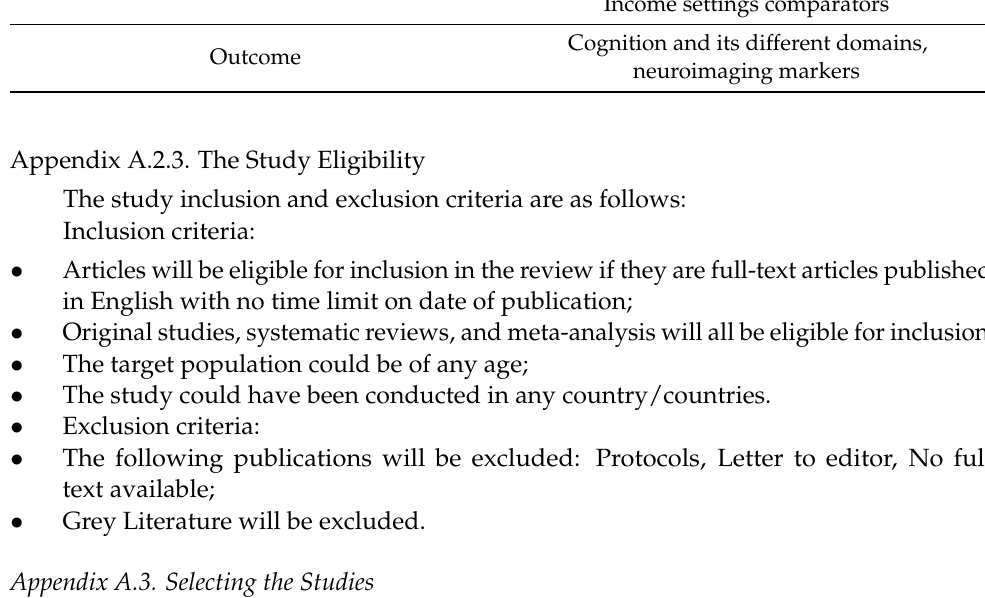
Table A1. Population, Investigated Exposure, Comparison, Outcome (PICO) Framework for Research question. Population Investigated exposure Comparison Outcome